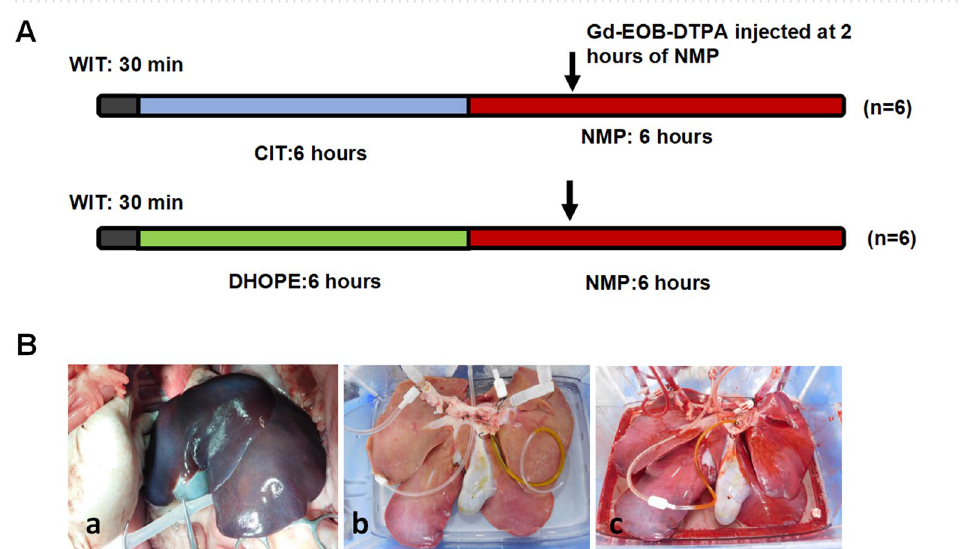
Figure 4. Correlation analysis between biliary R1 at early stage and biochemical parameters at 4 h of NMP. Correlation analysis was conducted between biliary R1 at 1 h after Gd-EOB-DTPA injection (60 ′ ) and conventional biochemical indexes at 4 h after NMP (ALT, perfusate lactate and biliary pH). ( A ) ALT value at 4 h after NMP had a strong correlation with values of biliary R1 (60 ′ ) (Spearman; r, − 0.854; p < 0.001). ( B ) Lactate value at 4 h after NMP had no significant correlation with values of biliary R1 (60 ′ ) (Spearman; r, − 0.476; p = 0.054). ( C ) There is a moderate between values of R1 (60 ′ ) and Biliary pH at 4 h after NMP (Spearman; r, 0.531; p = 0.028).